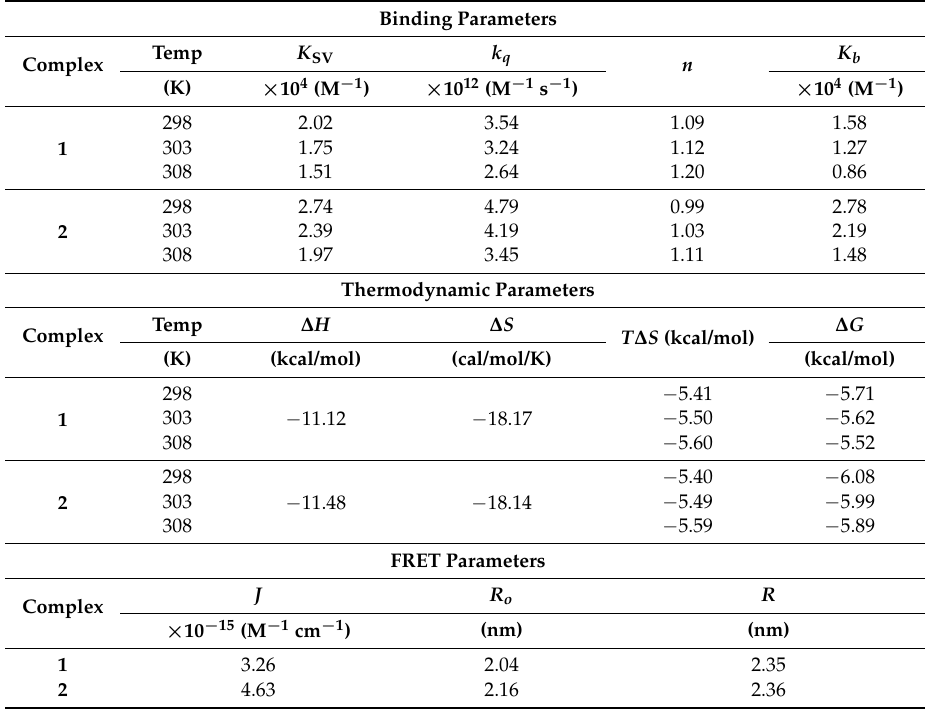
Table 1. Quenching constants and binding parameters for HSA–metal complex